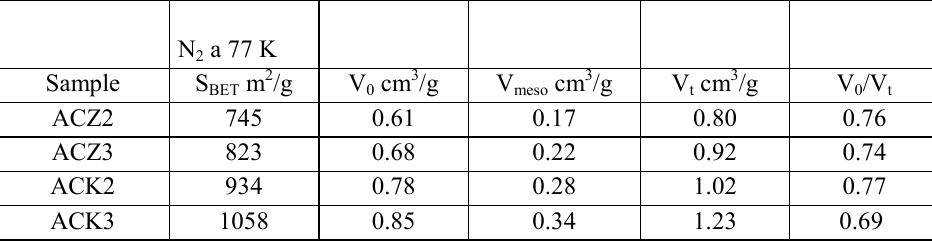
Table 1. Textural and properties of activated carbons